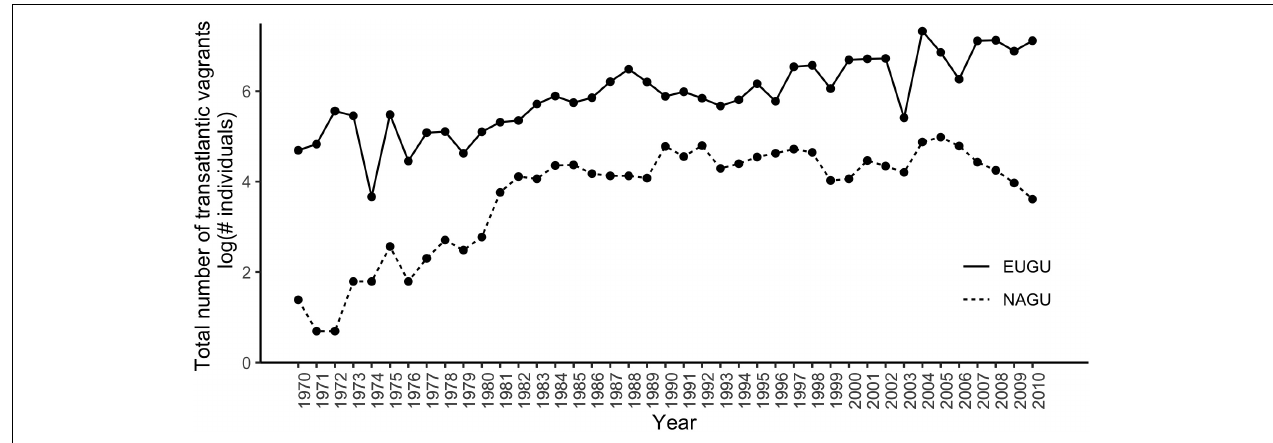
FIGURE 1 | Annual total number of transatlantic vagrants from Europe to eastern North America (EUGU, solid line) and from North America to Europe (NAGU, dashed line) during 1970–2010. There was a strong positive correlation between the annual number of European and North American transatlantic vagrants (Spearman rank correlation r s = 0.63, p = 1.04 × 10 − 05 ).